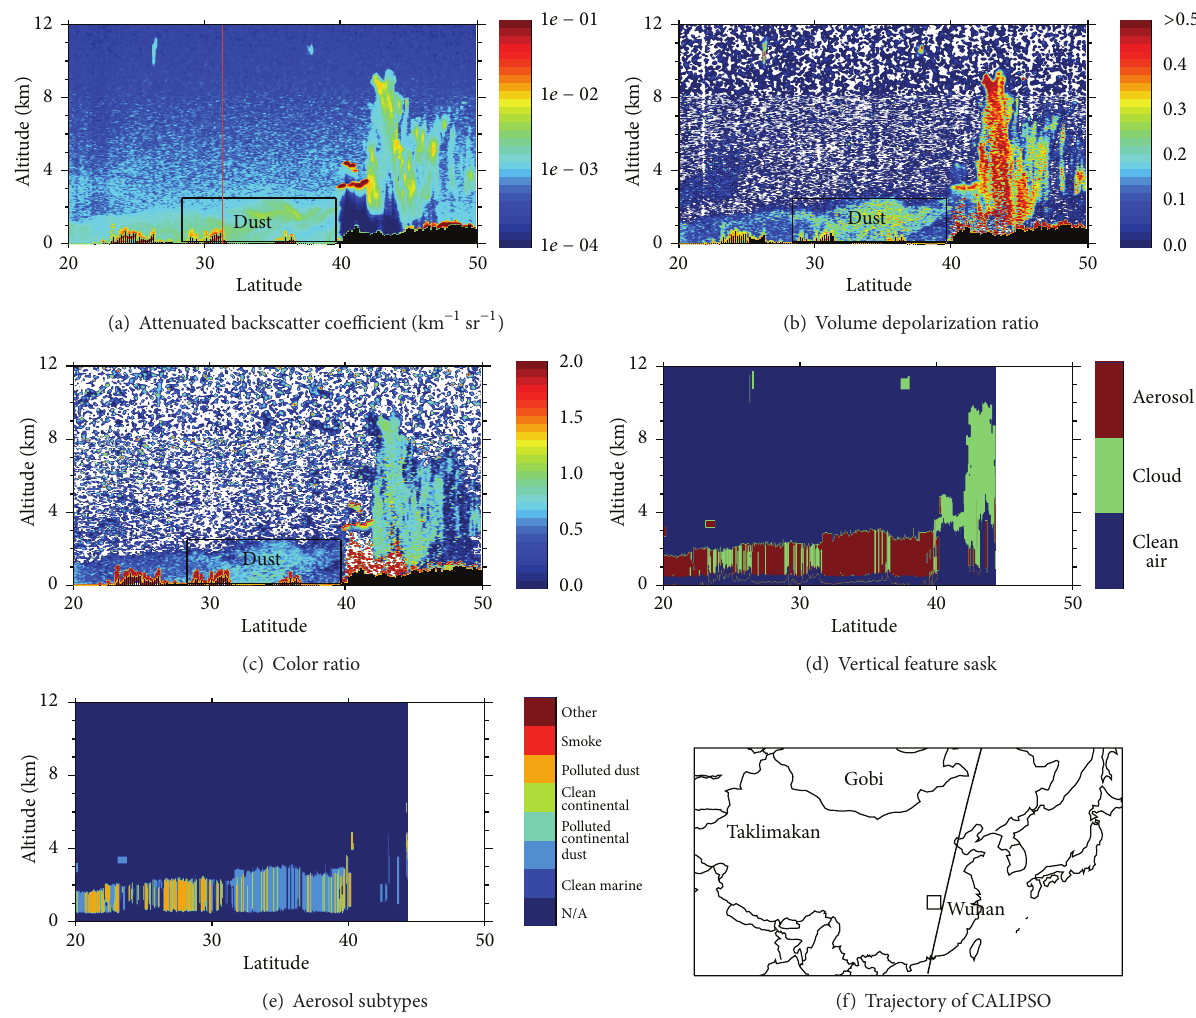
Figure 9: Same as Figure 5, except for the date, 8 December 2010. The corresponding CALIPSO orbit is